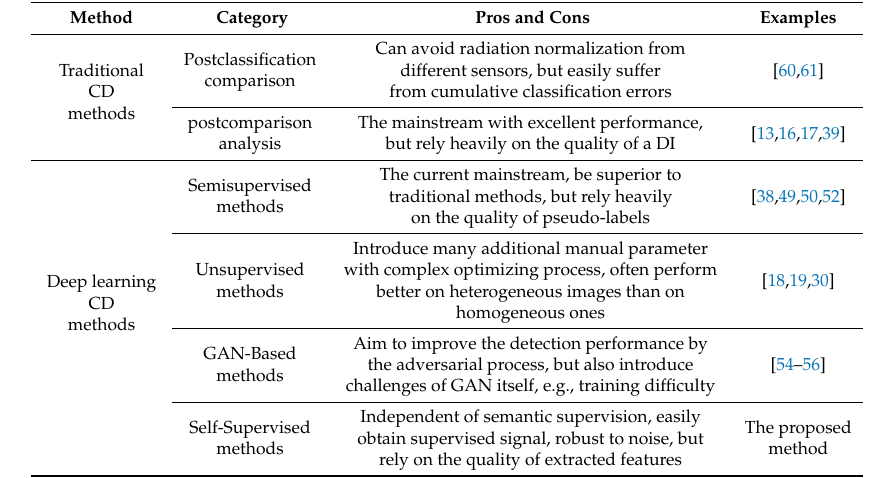
Table 1. Summary of contemporary CD